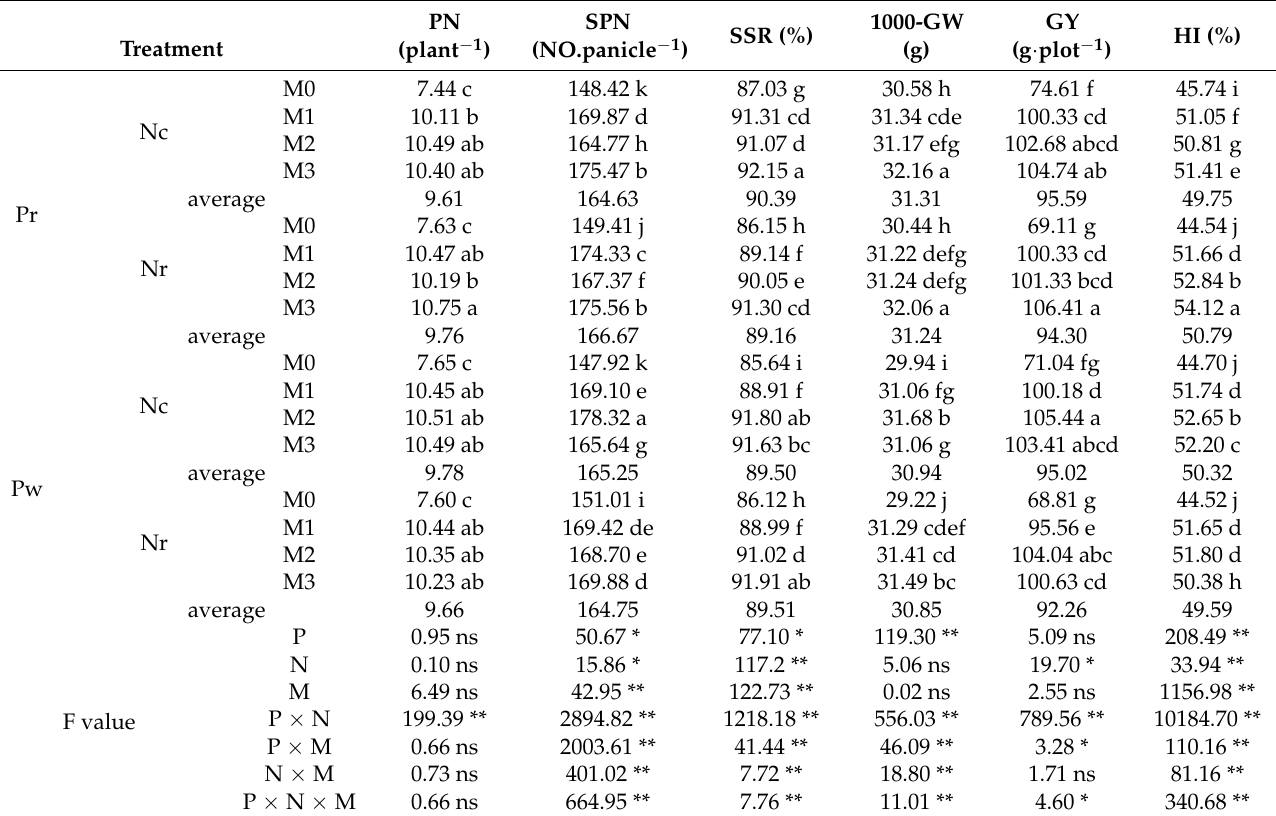
Table 4. Effects of N management on biomass, grain yield and its components, and the HI of rice.